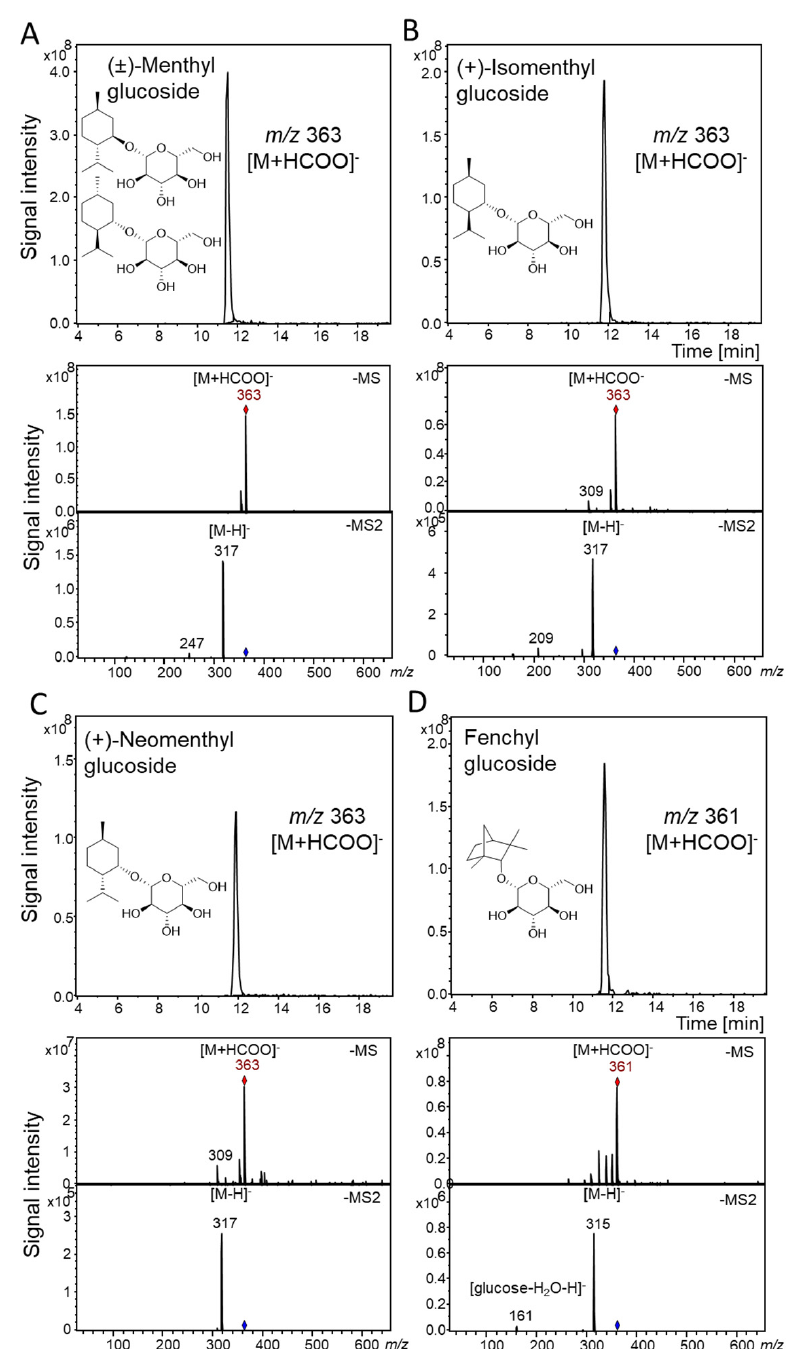
Figure 2. Qualitative in vitro substrate screening of UGT93Y1 with (±) ‐ menthol ( A ), (1 S ,2 R ,5 R ) ‐ (+) ‐ isomenthol ( B ), (1 S ,2 S ,5 R ) ‐ (+) ‐ neomenthol ( C ) and fenchyl alcohol ( D ) by LC ‐ MS. Selected ion chromatograms ( m/z 363 and 361), mass spectra in negative mode ( ‐ MS) and product ion spectra of the pseudo ‐ molecular ions ( m/z 363 and 361; ‐ MS2) are shown.